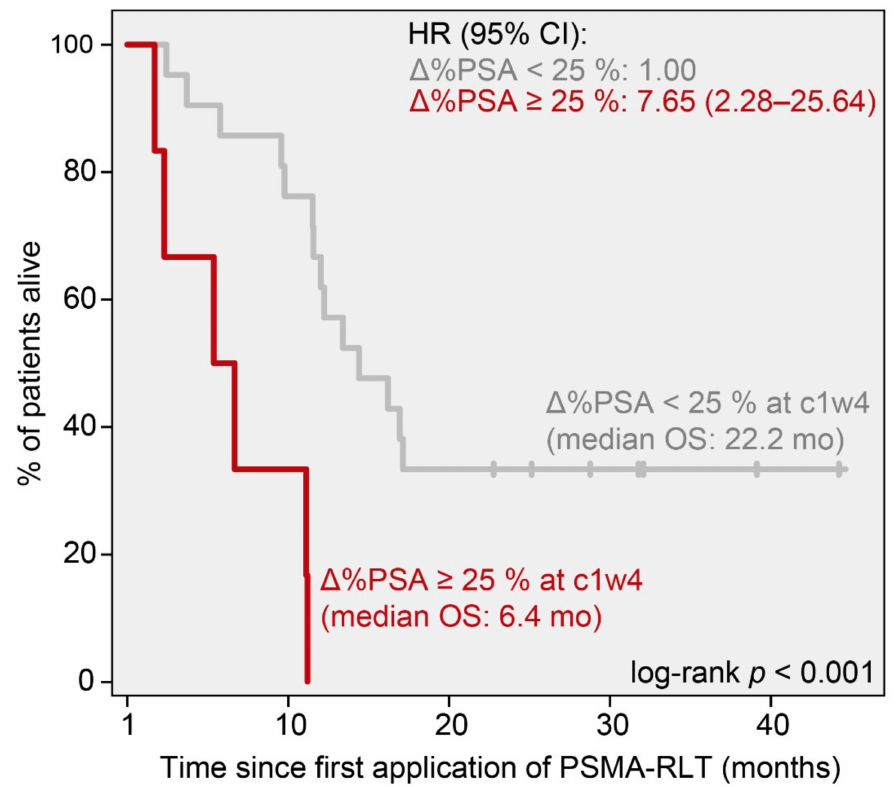
Figure 4. Kaplan–Meier curves for the overall survival (OS) of patients stratified by a PSA increase of at least 25% ( ∆ %PSA ≤ 25%) at four weeks (c1w4). Median OS and hazard ratios (HR) with 95% confidence interval (95% CI) are given for each